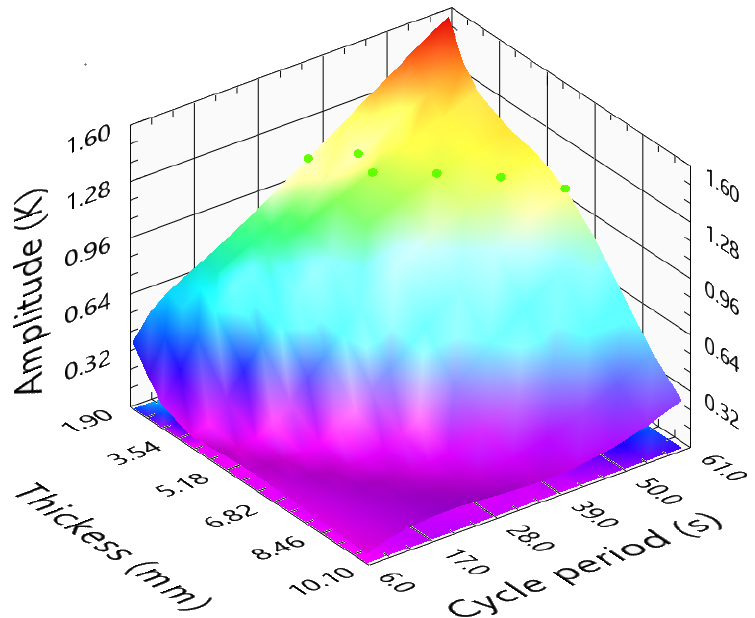
Figure 14. Amplitude difference function of PMMA sample thickness and cycle